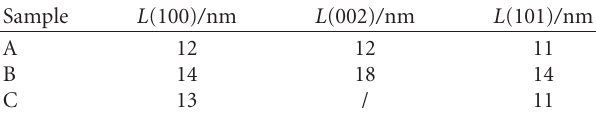
Table 3: Average nanocrystal sizes, L ( hkl ), estimated from (100), (002), and (101) reflections, from conventional XRD measure- ments.